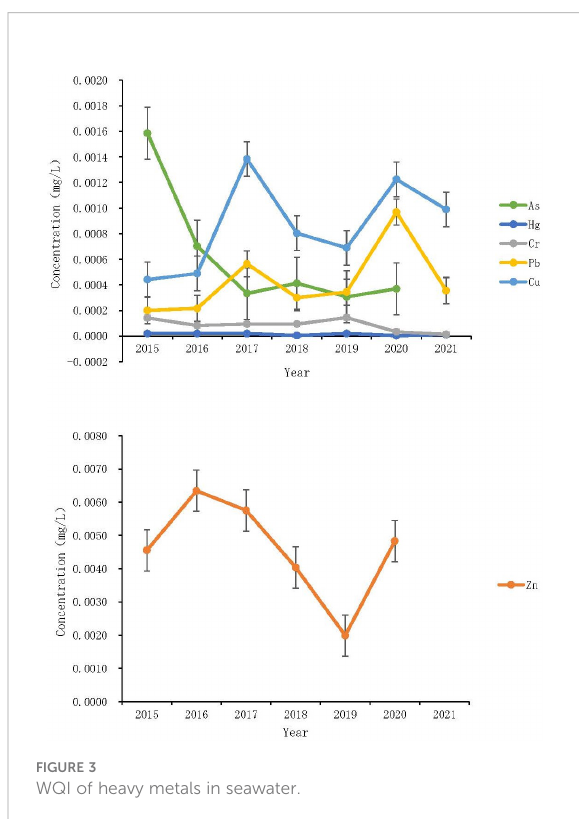
FIGURE 3 WQI of heavy metals in